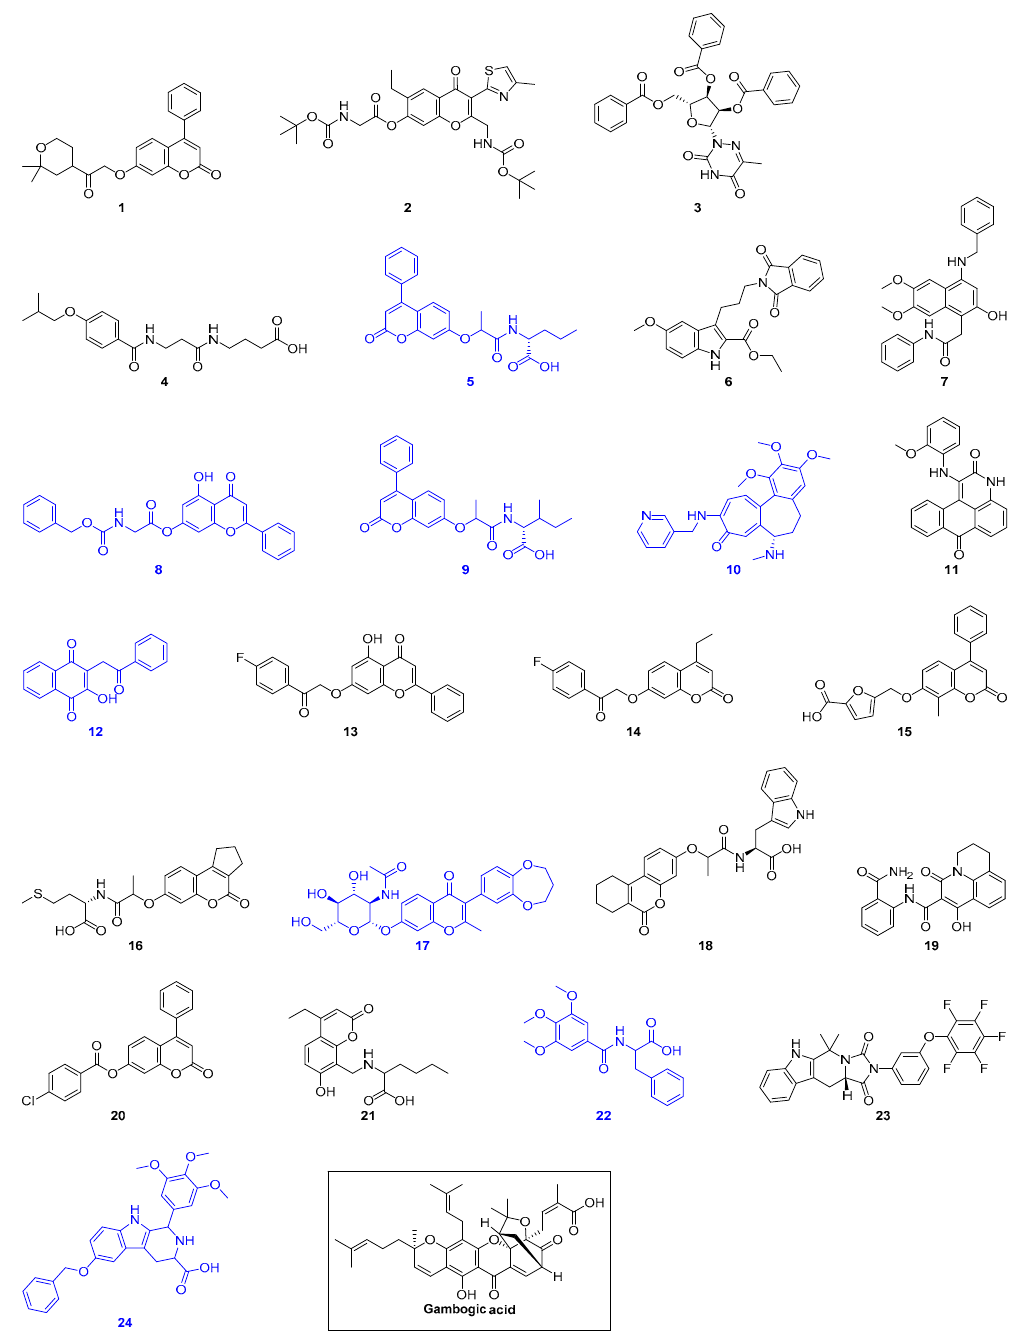
Figure 1. Structures of the 24 virtual hits and gambogic acid (a reported Hsp90 MD inhibitor). Blue indicates compounds that show binding to Hsp90 α / β MD as monitored by intrinsic tryptophan fluorescence spectroscopy.